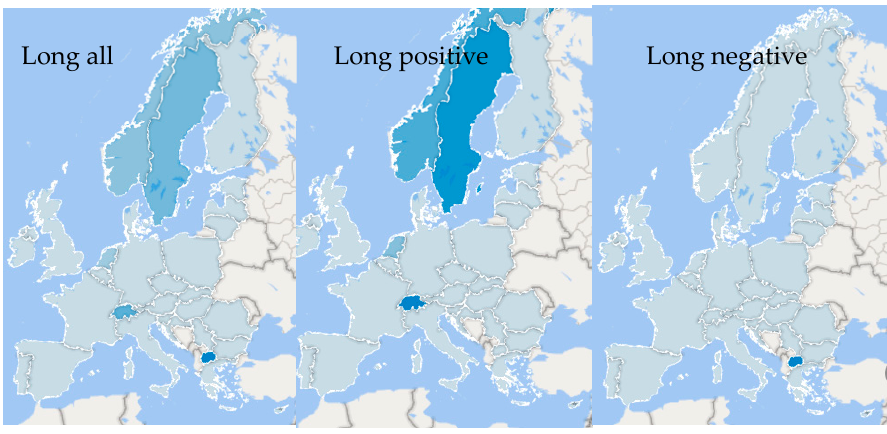
Figure 19. Number of precedence by country, long precedencies, group EM by effect. Geospatial distribution.